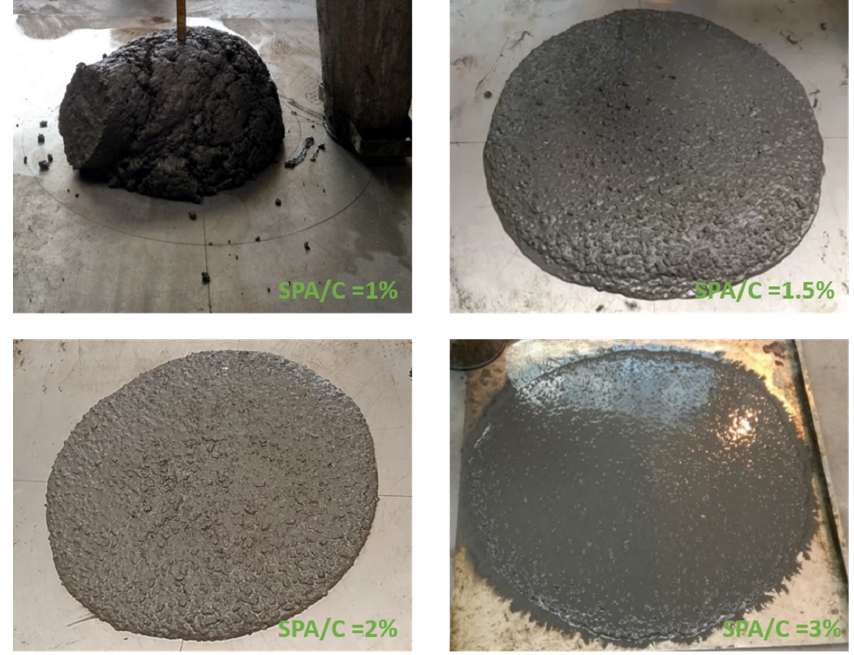
Figure 10. Detail of slump flow test.